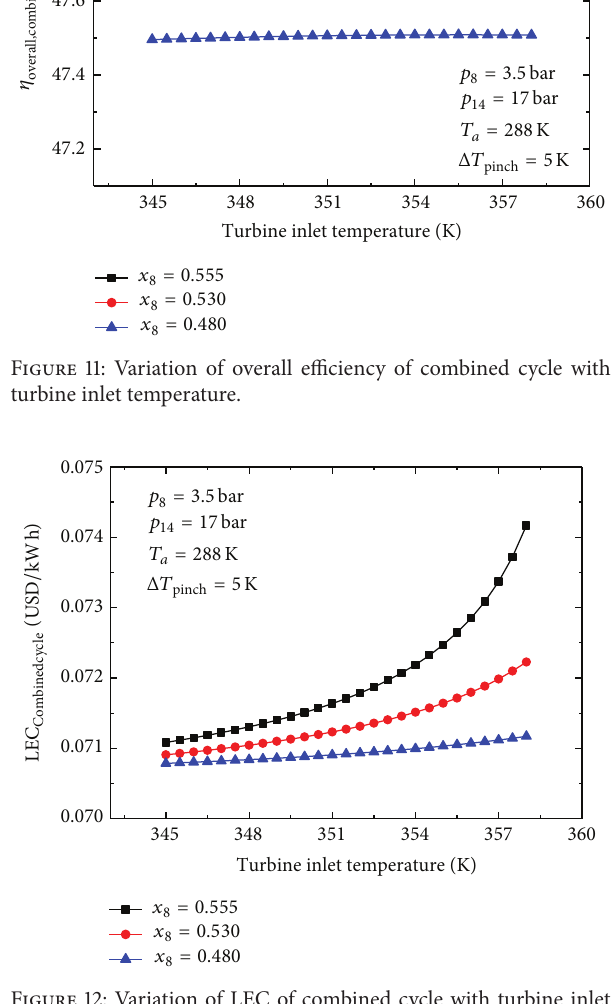
Figure 12: Variation of LEC of combined cycle with turbine inlet